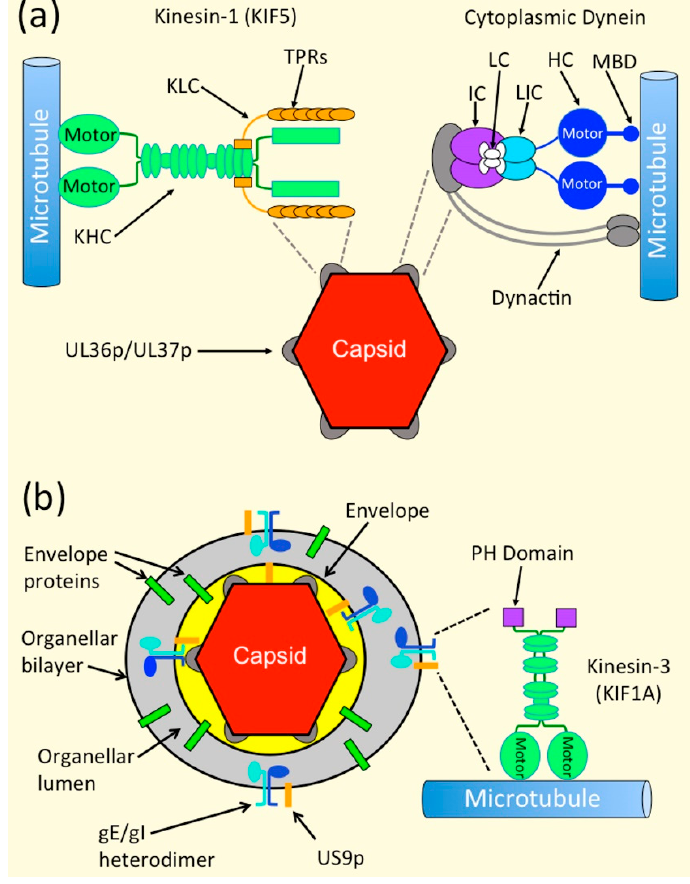
Figure 2. ( a ) During egress, but prior to cytoplasmic envelopment, the alphaherpesvirus capsid (red hexagon) recruits the motors kinesin-1 (left) and dynein/dynactin (right) for association with MTs (blue cylinders). The motors may bind via the inner tegument proteins UL36p/UL37p (grey ovals) at the capsid vertices. Left of panel: Kinesin-1 KHCs are shown in green, and the motor domain is indicated. Ovals represent coiled-coil domains, circles represent hinge regions. The KLCs, with their TPRs, are shown in orange (adapted from [53]). Right of panel: Dynein HC is shown in dark blue, and motor region and MT-binding domain (MBD) are indicated. Additional subunits are the intermediate chains (IC), light intermediate chains (LIC) and light chains (LC). The dynactin complex is shown in grey. Although dynein commonly binds cargo via dynactin, this may not necessarily be the case for HSV-1 capsids. Broken grey lines indicate that, while UL36p/UL37p may recruit kinesin-1 and dynein during egress, the molecular details are unknown; ( b ) The organelle-associated enveloped virion (OEV), following capsid cytoplasmic envelopment. Capsid, with UL36p/UL37p inner tegument is shown as in ( a ). Outer tegument is shown in yellow. The mature, enveloped alphaherpesvirus particle resides within the lumen (grey) of its envelopment organelle. Multiple virally encoded membrane proteins (green bars) are imbedded in the viral envelope and bounding organellar membrane. The gE/gI heterodimer is shown as light and dark blue lollipops, and US9p as an orange bar. Broken grey lines indicate that gE/gI-US9p in the organellar bilayer recruits kinesin KIF1A, shown at right. The activated KIF1A motor is a homodimer [green chains, with coiled-coils and motor domains, as shown for the KHC in ( a )]. Pleckstrin homology (PH) domains are indicated by purple squares. See text for more